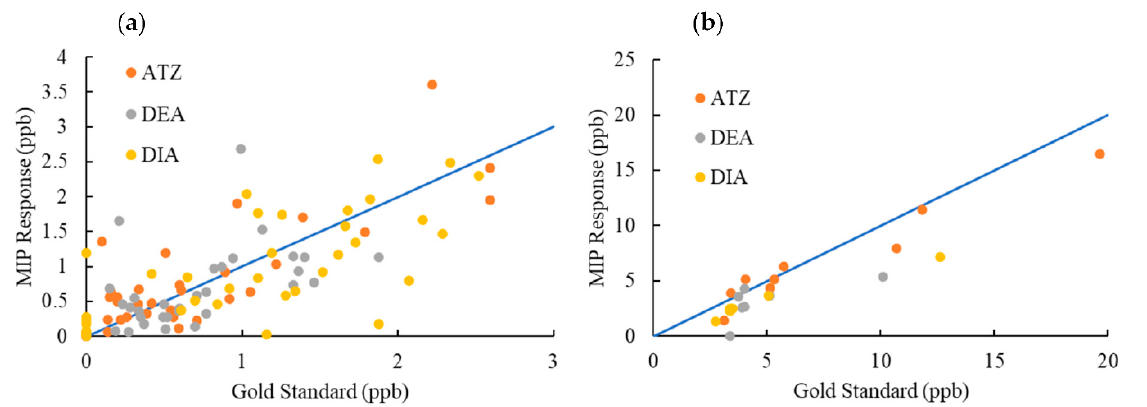
Figure 11. Degree of agreement (concordance) between MIP response and LCMS/MS measurements (gold standard); ( a ) 0 to 3 µ g/L, ( b ) >3 µ g/L.